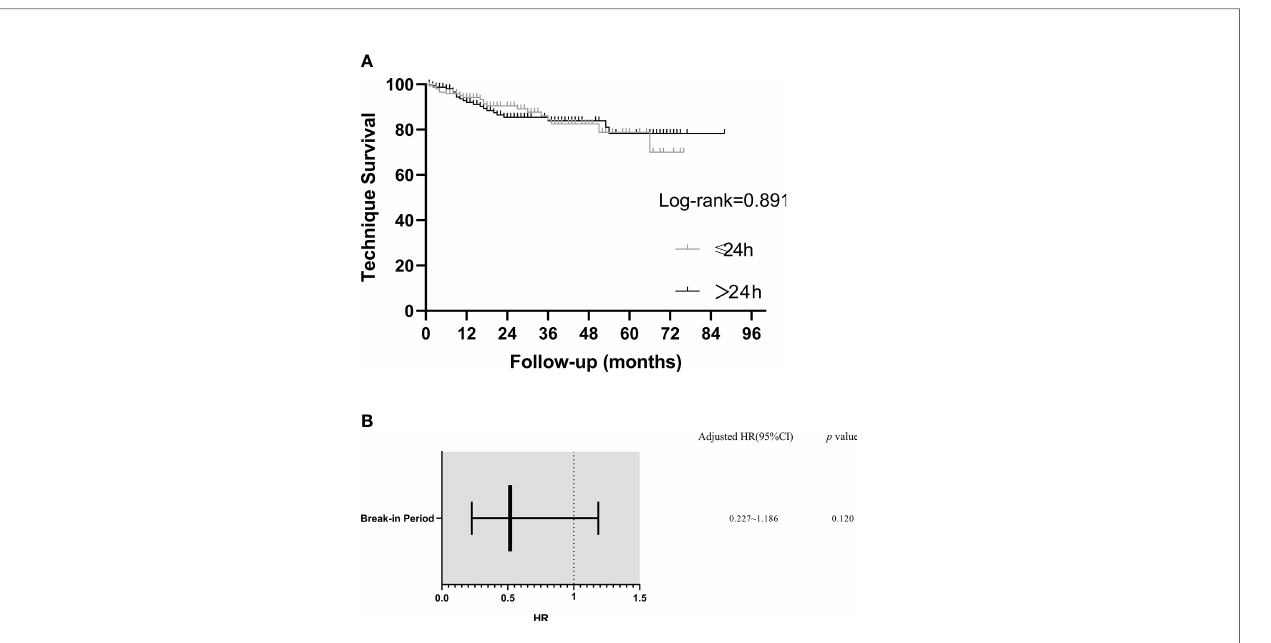
FIGURE 3 | Kaplan – Meier plot of technique survival analysis in different break-in period group and predictors of technique failure (Cox Multivariate Analysis). (A) Technique survival curves. (B) Predictors of technique failure. Model was adjusted for peritoneal dialysis center, age, hypertension, white blood cells, blood urea nitrogen and blood potassium. HR, hazard ratio; CI, con fi dence interval.